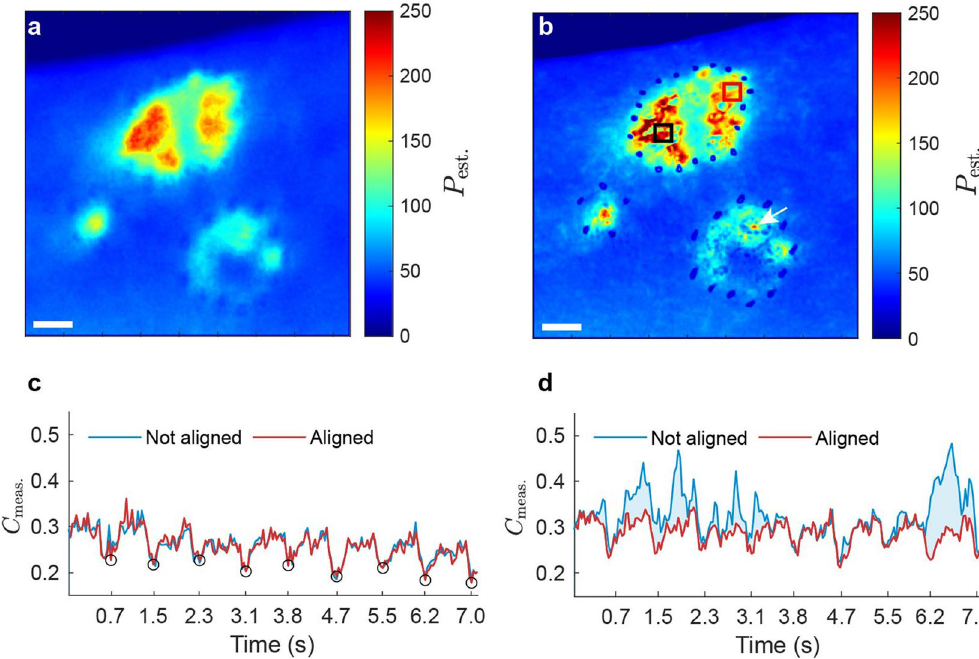
Figure 7. Spatiotemporal analysis of speckle frames alignment. Data of experiment index 6 is shown. ( a ) Temporally averaged perfusion map of a representative handheld measurement without alignment. P est. : estimated perfusion. Scale bars, 10 mm. ( b ) Temporally averaged perfusion map of the same measurement after alignment. White arrow indicates a small region with a rather higher perfusion value which is not distinguishable without alignment. ( c ) Temporal fluctuation of the measured speckle contrast ( C meas. ) during the corresponding handheld measurement with and without alignment. The region of interest for the calculation is shown as the black square in ( b ). Open circles: manually selected sudden drops in the speckle contrasts possibly driven by the heartbeats. ( d ) Measured speckle contrast versus time during the handheld measurement where the calculation region is shown as the red square in ( b